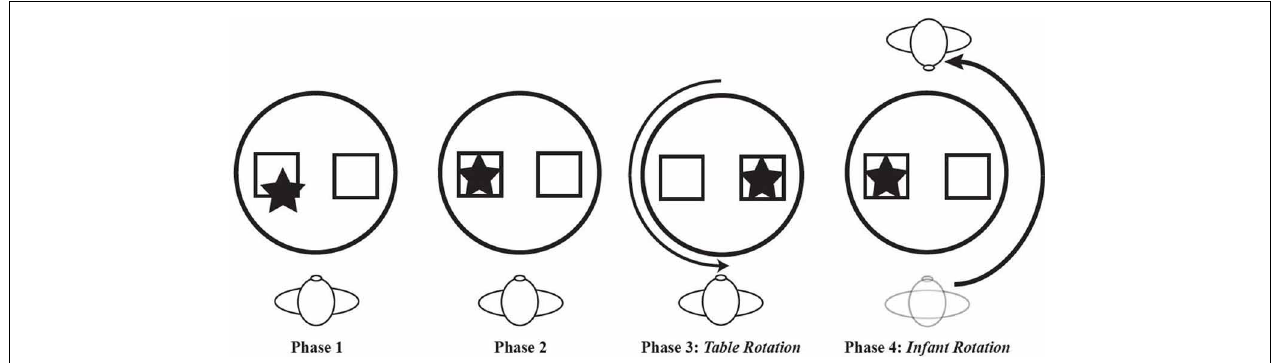
FIGURE 6 | Four phases of a hypothetical spatial search task. In phase 1, the object is partially hidden by an occluder. In phase 2, the object is completely hidden by the occluder. In phase 3, the object is completely